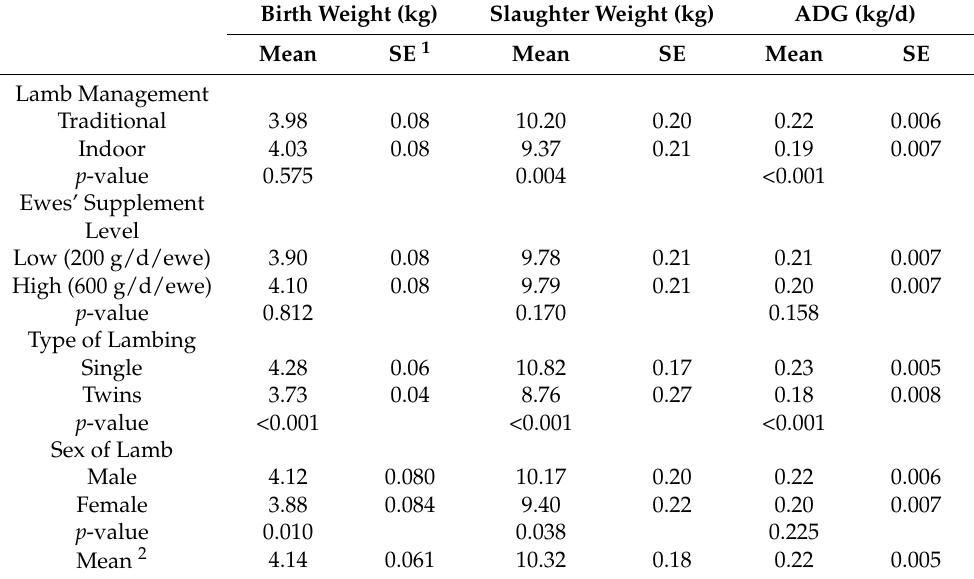
Table 2. Least-squares means for initial body weight (birth weight), final body weight (at slaughter after 28 days suckling period), and average daily gain (ADG) of Sarda suckling lambs. Birth Weight (kg) Slaughter Weight (kg) ADG (kg/d) Mean SE